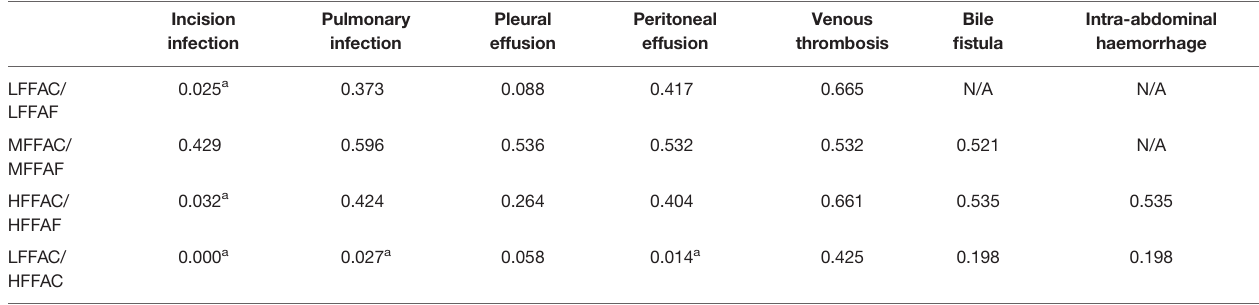
TABLE 3 | P value among the indicated